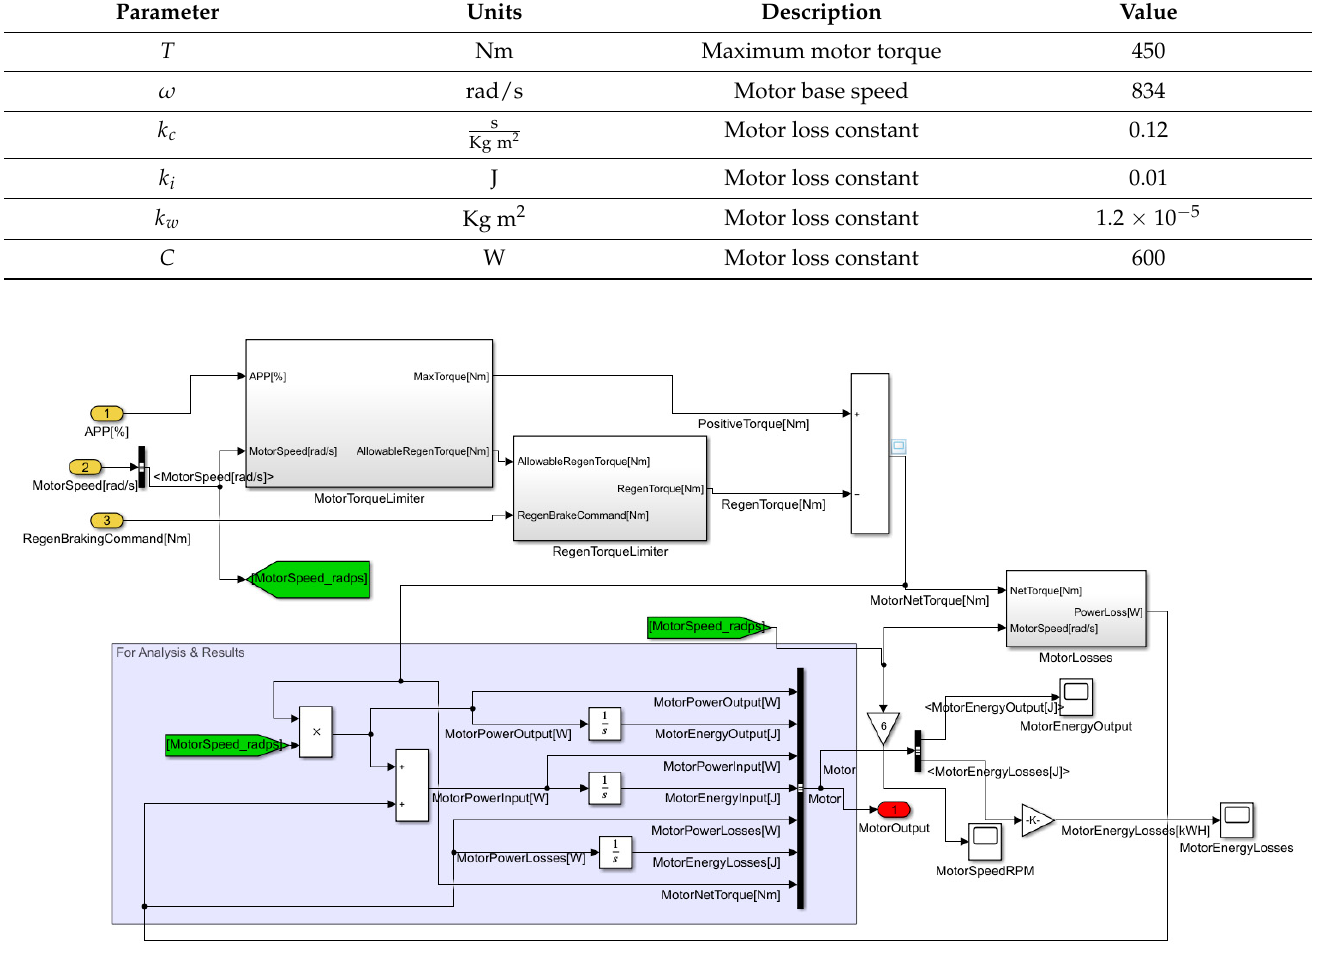
Figure 11. Electric motor model with motor loss model calculations. Adapted from [16], MathWorks: 2020.